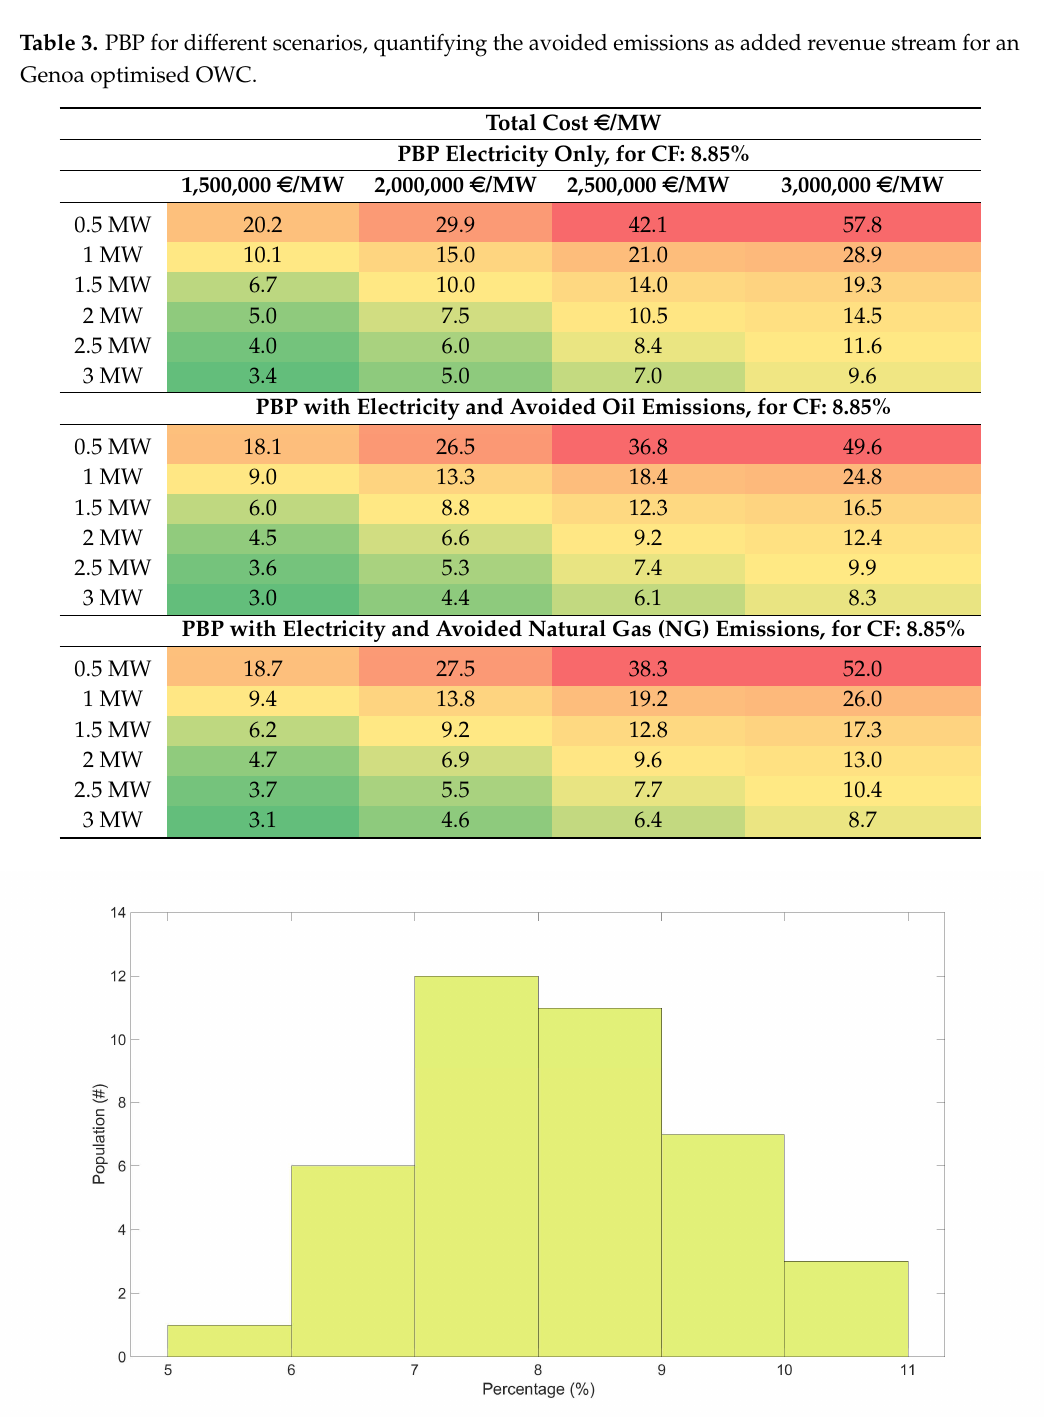
Figure 6. Probability density for the percentage of operative hours between 6:00 p.m.–8:00